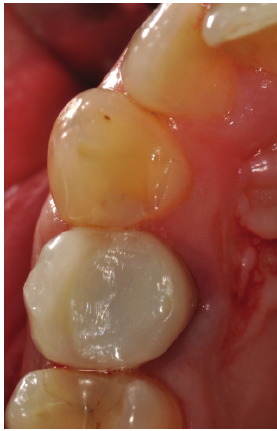
Figure 2: Occlusal view of the prosthetic crown on the upper right first premolar.